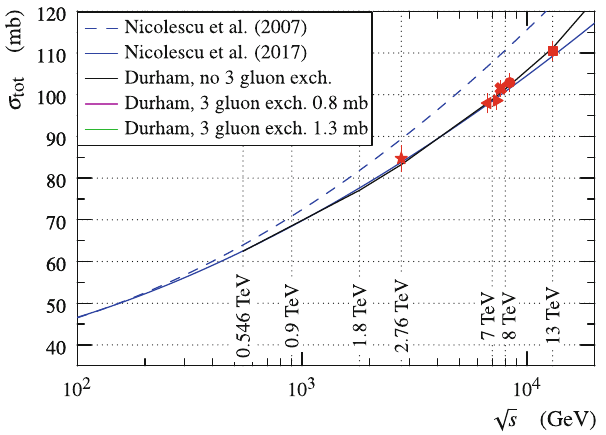
Fig. 21 PredictionsofthemodelbyNicolescuetal.(dashedbluecurve from [30], solid blue curve from [51]) and the Durham model [20] (including crossing-odd contribution from [19]) compared to the ref- erence TOTEM measurements (red markers). The σ tot point at 13TeV corresponds to the weighted average in Eq. (21). The two ρ points at 13TeV correspond to the two cases discussed in Sect. 6.2: the left